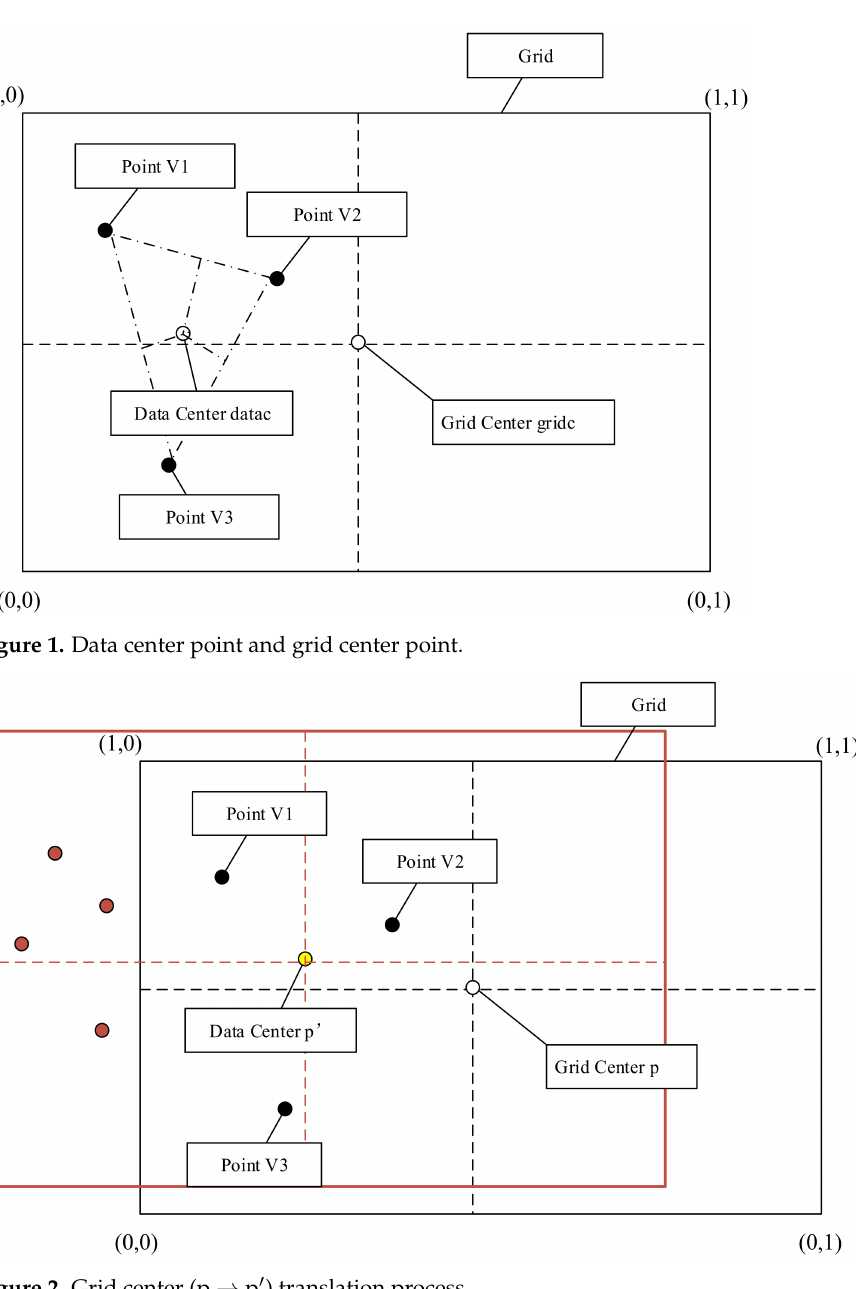
Figure 2. Grid center (p → p (cid:48) ) translation